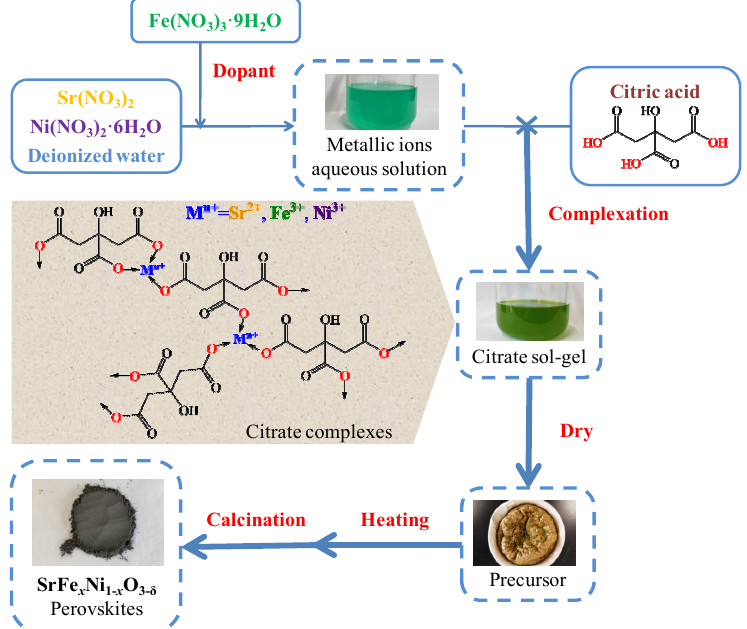
Figure 1. Schematic diagram of the fabrication process of the SrFe x Ni 1− x O 3−δ perovskites.